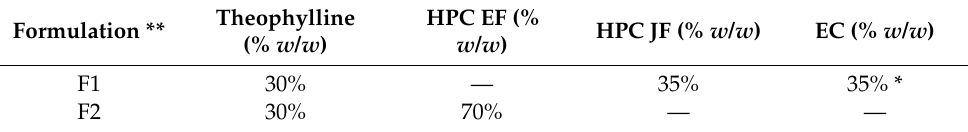
Table 1. Composition of studied formulations. Formulation **